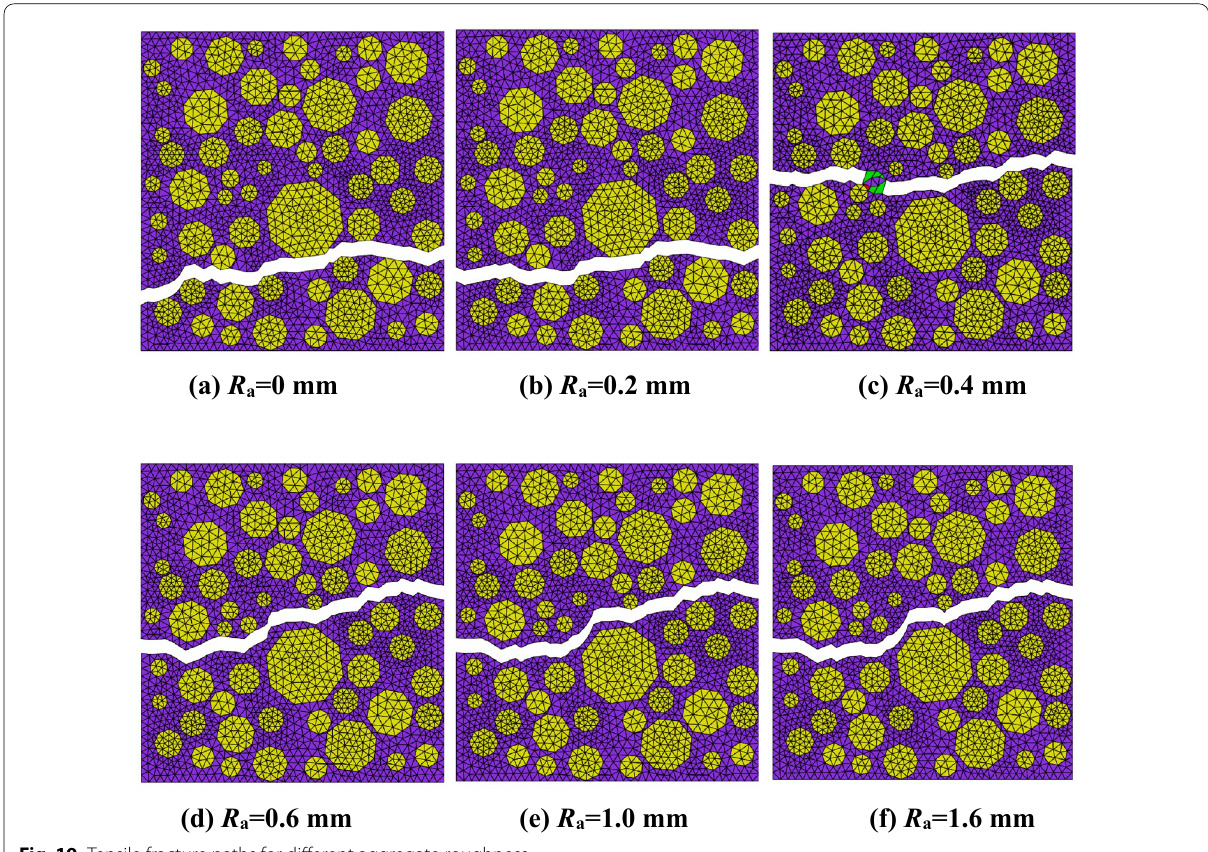
Fig. 19 Tensile fracture paths for different aggregate